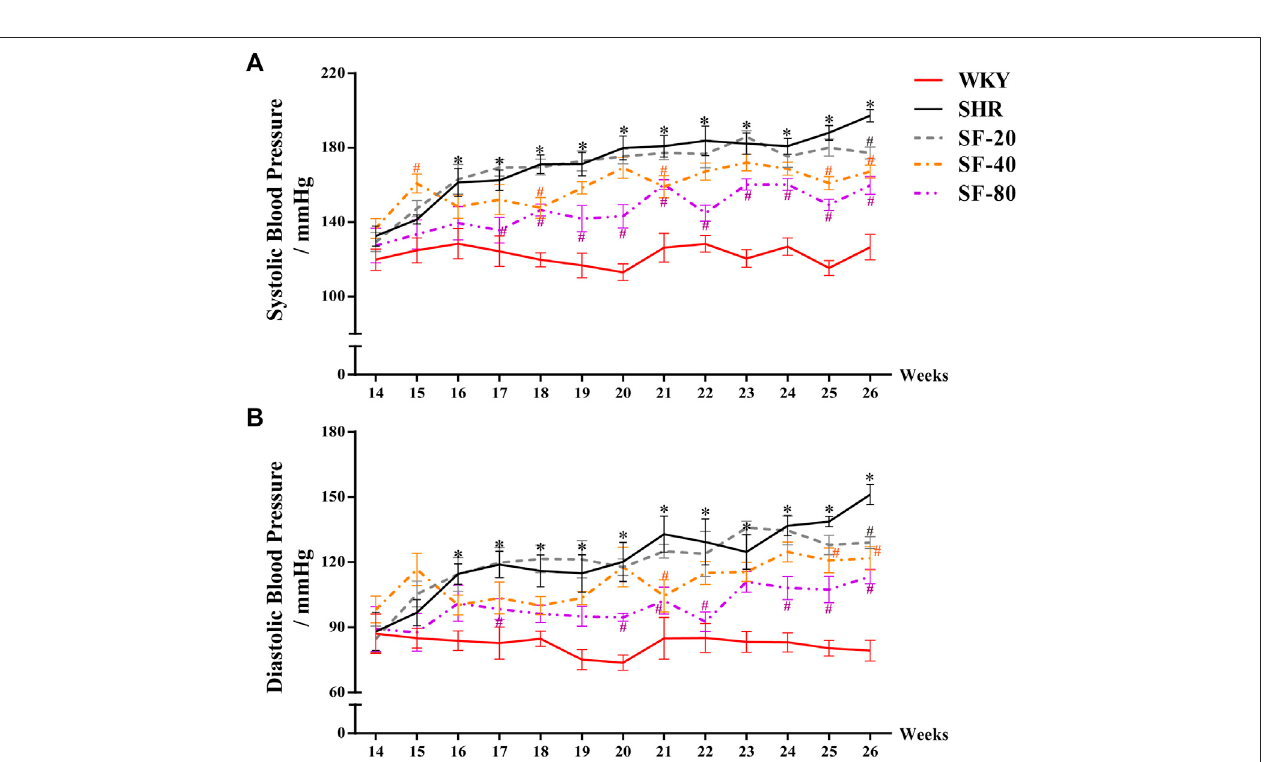
FIGURE 1 | Effect of SF on blood pressure in SHRs. SF-20, SF-40, and SF-80 were administered to SHRs for 12 weeks; SHRs and age-matched male WKY rats were given distilled water as model (SHRs) and normal (WKY) controls. (A) Effect of SF on systolic blood pressure in SHRs ( n (cid:1) 8). (B) effect of SF on diastolic blood pressure in SHRs ( n (cid:1) 8). Data are presented as mean ± SEM. *signi fi cantly different from WKY rats at p < 0.05; # signi fi cantly different from SHRs at p < 0.05.